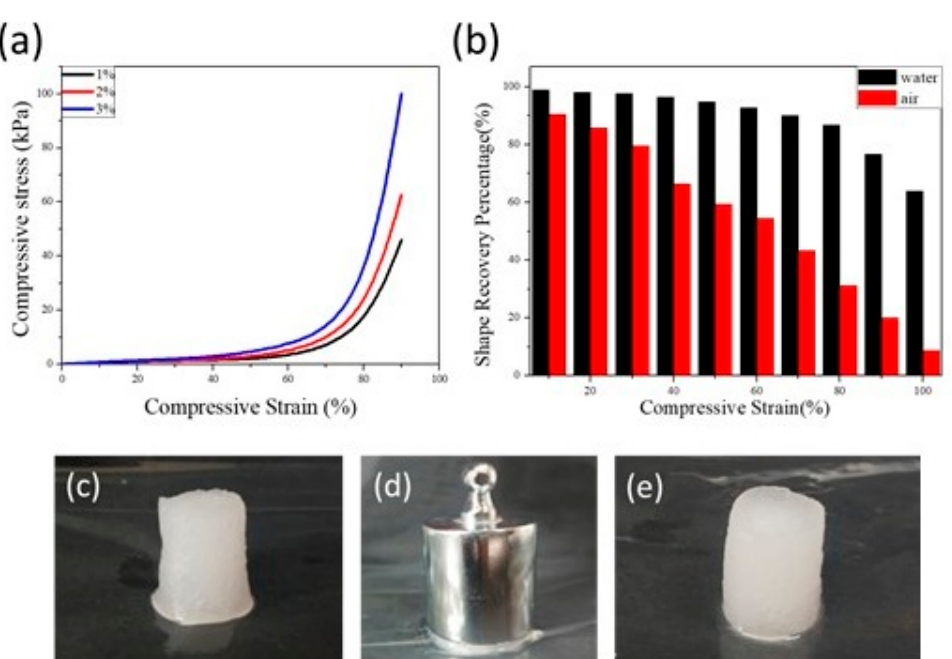
Figure 4. ( a ) Compressive stress–strain curves of water-saturated CNF Aerogels prepared, ( b ) Shape recovery percentage of CNF Aerogel under different compressive strains (0~95%) after 10 cyclic compressions both in water and air, ( c )–( e ) Photograph of manually compressed water-saturated CNF Aerogel.